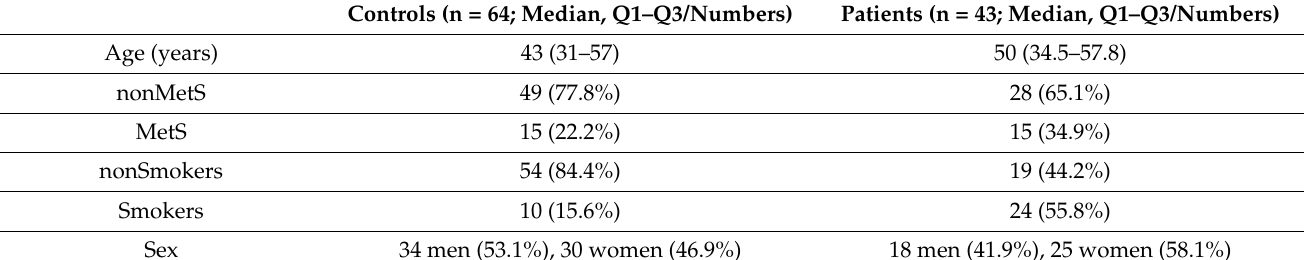
Table 1. Demographic data.